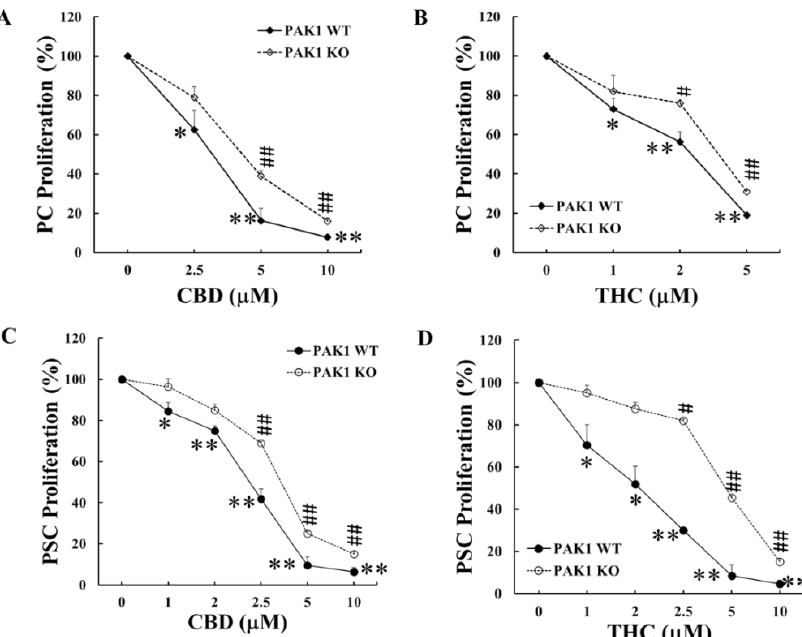
Figure 2. PAK1 knockout reduced the inhibition of CBD or THC on proliferation of PC and PSC cells. PAK1 wild type (WT) and knockout (KO) pancreatic cancer (PC) ( A , B ) or pancreatic stellate cells (PSC) ( C , D ) were treated with CBD ( A , C ) or THC ( B , D ) for 48 h. Cell proliferation was determined by MTT assay. The values from non-treated controls of either PAK1 WT or KO cells were taken as 100% for the respective cell line. The data were summarized from three independent sets of experiments. *, p < 0.05; **, p < 0.01 compared to PAK1 WT control. #, p < 0.05; ##, p < 0.01 compared to PAK1 KO control.